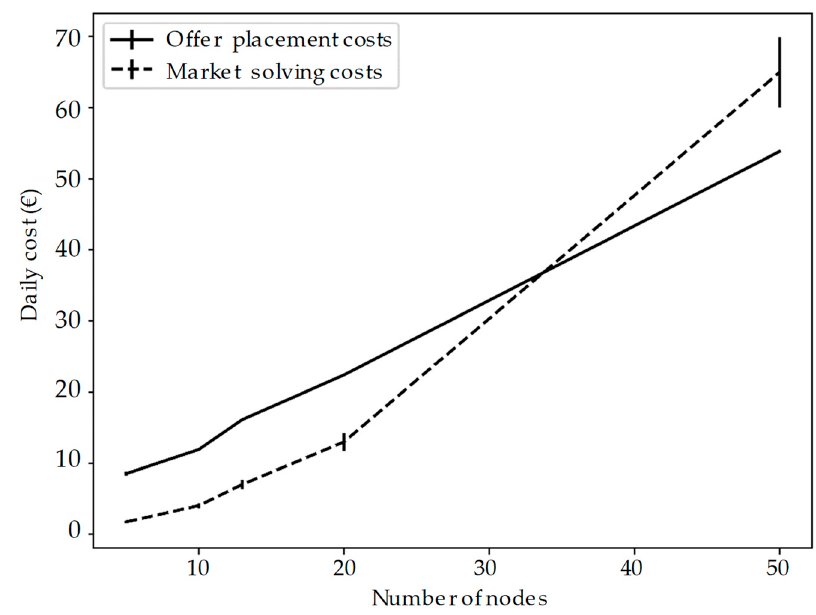
Figure 10. This error plot shows the evolution of daily costs for both offer placement and market solving for test networks of various sizes.